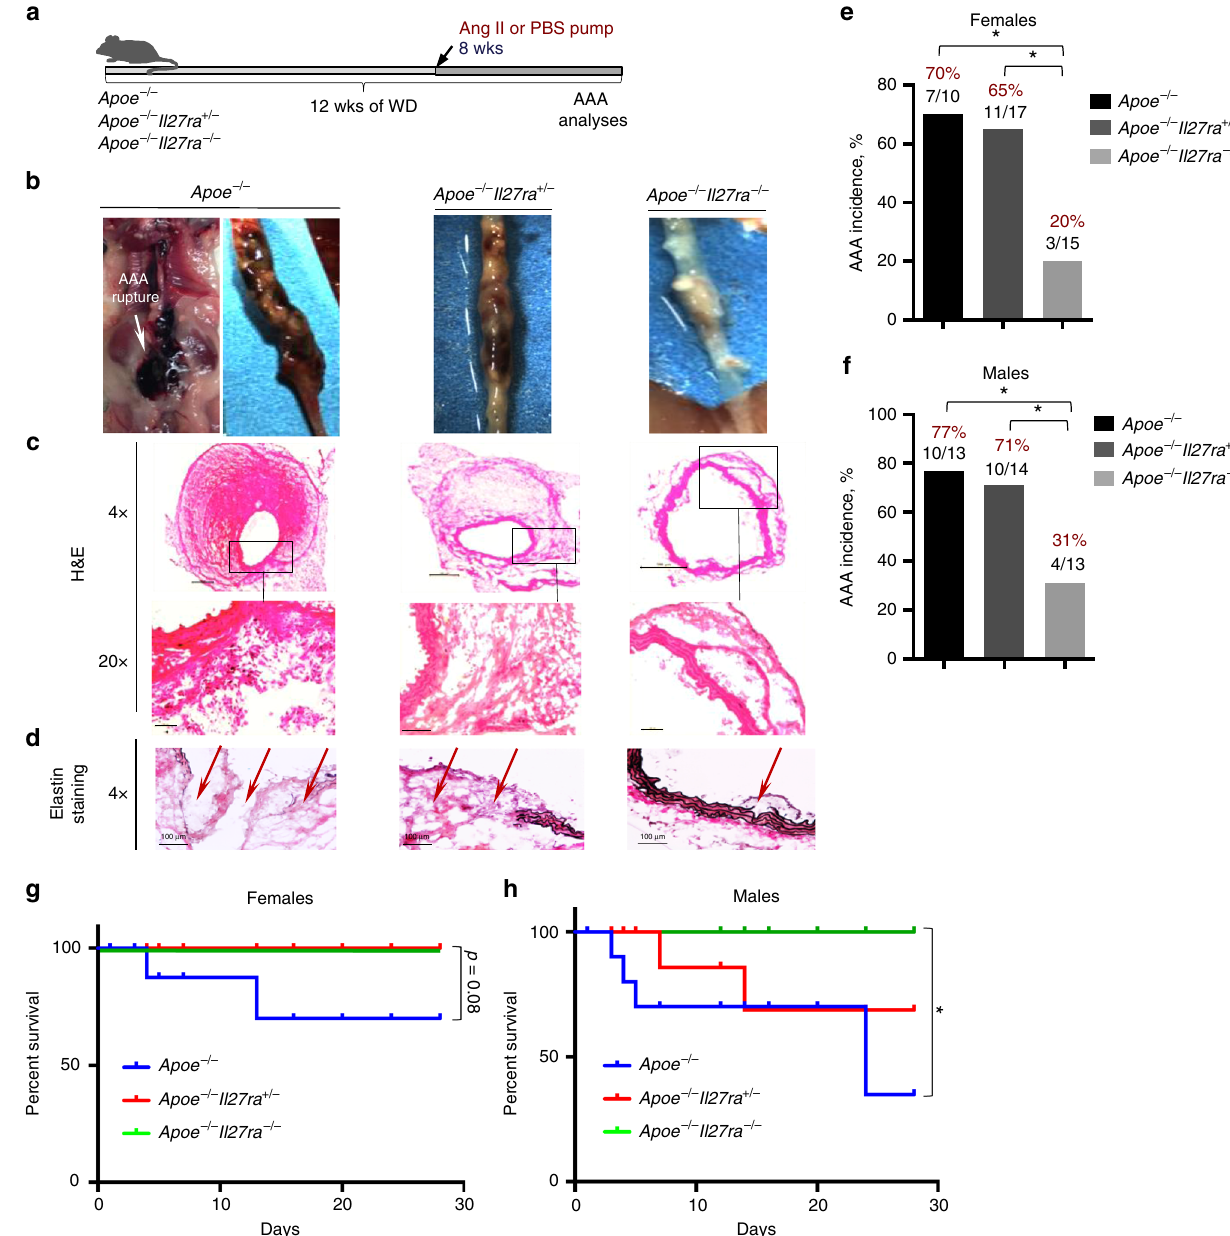
Fig. 1 IL-27R de fi ciency protects from Ang II-induced AAA development. a Scheme of the experiment. Apoe − / − , Apoe − / − Il27ra + / − and Apoe − / − Il27ra − / − female and male mice were fed the WD for overall period of 12 weeks, and during last 4 weeks of feeding they were implanted with osmotic pumps containing Ang II or PBS. b Representative images of suprarenal aortas with developed AAA. c Hematoxylin and eosin (H&E) staining, d Verhoeff-Van Gieson staining of AAA frozen sections from Apoe − / − , Apoe − / − Il27ra + / − , or Apoe − / − Il27ra − / − mice after Ang II infusion. Scale bars, 100 μ m. Black-elastin, red-collagen, blue-nuclei. Arrows indicate ruptured elastic lamina. b – d Representative images from male mice. e , f AAA incidence among Apoe − / − ( n = 10), Apoe − / − Il27ra + / − ( n = 17), and Apoe − / − Il27ra − / − ( n = 15) female ( e ) and Apoe − / − ( n = 13), Apoe − / − Il27ra + / − ( n = 14), and Apoe − / − Il27ra − / − ( n = 13) male mice ( f ). * p <0.05, Fisher ’ s exact test (two-sided). g , h Survival curves for Apoe − / − (2 / 10 died ) , Apoe − / − Il27ra + / − (0/17 died), and Apoe − / − Il27ra − / − (0/15 died ) female ( g ) and Apoe − / − (4/13 died), Apoe − / − Il27ra + / − (2/14 died), and Apoe − / − Il27ra − / − (0/13 died ) male mice ( h ) during 28 days of Ang II infusion. * p <0.05, long-rank test. Data are mean±SEM from at least three independent (Ly6C hi and Ly6C low ) as well as neutrophils (Ly6G + ) in AAA revealed a signi fi cant reduction in the percentage and number of hematopoietic CD45 + cells in Apoe − / − Il27ra − / − mice compared lesions of Apoe − / − Il27ra − / − mice compared with IL-27R- with Apoe − / − Il27ra + / − controls (Fig. 2a and Supplementary suf fi cient controls (Fig. 2c). Immuno fl uorescence staining of iso- Fig. 4). Among CD45 + cells, the number of CD11b + , CD11b + lated AAAs con fi rmed limited adventitial accumulation of CD11c + , and CD11c + myeloid cell subsets were also CD11b + myeloid cells, particularly Ly6G + neutrophils in AAA signi fi cantly diminished in aortas of Apoe − / − Il27ra − / − mice lesions of Apoe − / − ll27ra − / − mice (Fig. 2d). Quantitative reverse- (Fig. 2b). We observed a striking reduction in monocyte subsets transcriptase PCR (Q-RT-PCR) analysis revealed the reduction of